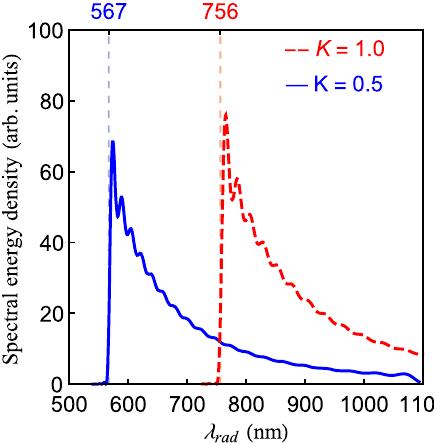
FIG. 4. Linear polarization: For a single electron the on-axis intensity of the first three odd harmonics vs K at a distance of 100 λ u . The electron energy is 60 MeV.